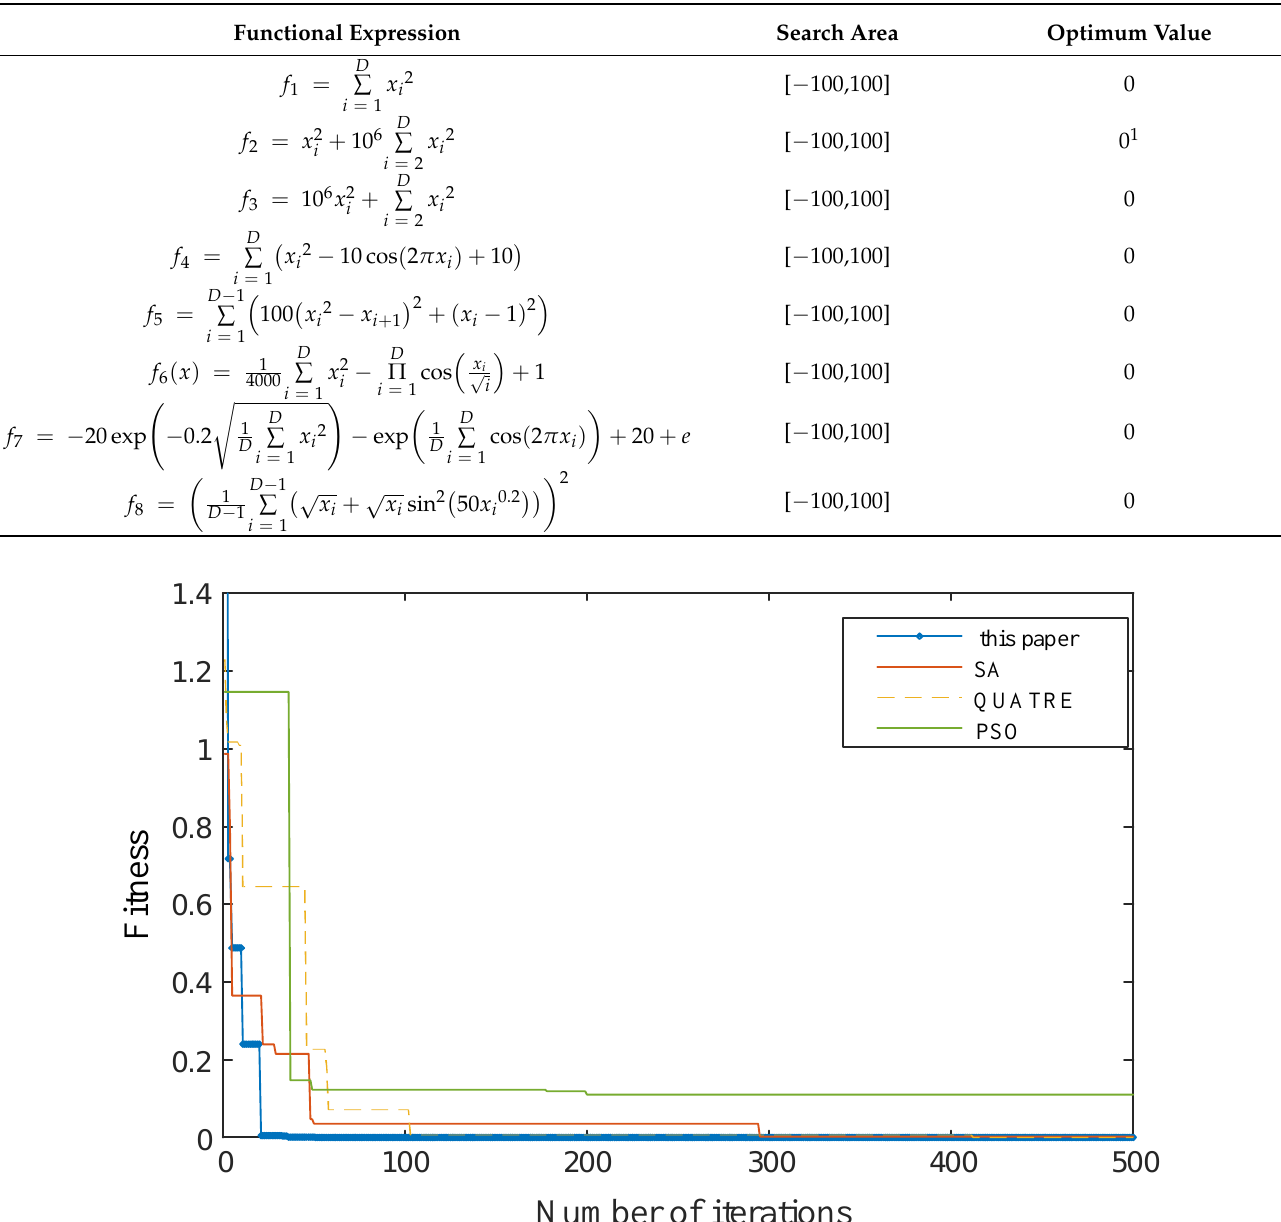
Table 1. Eight general benchmark functions.